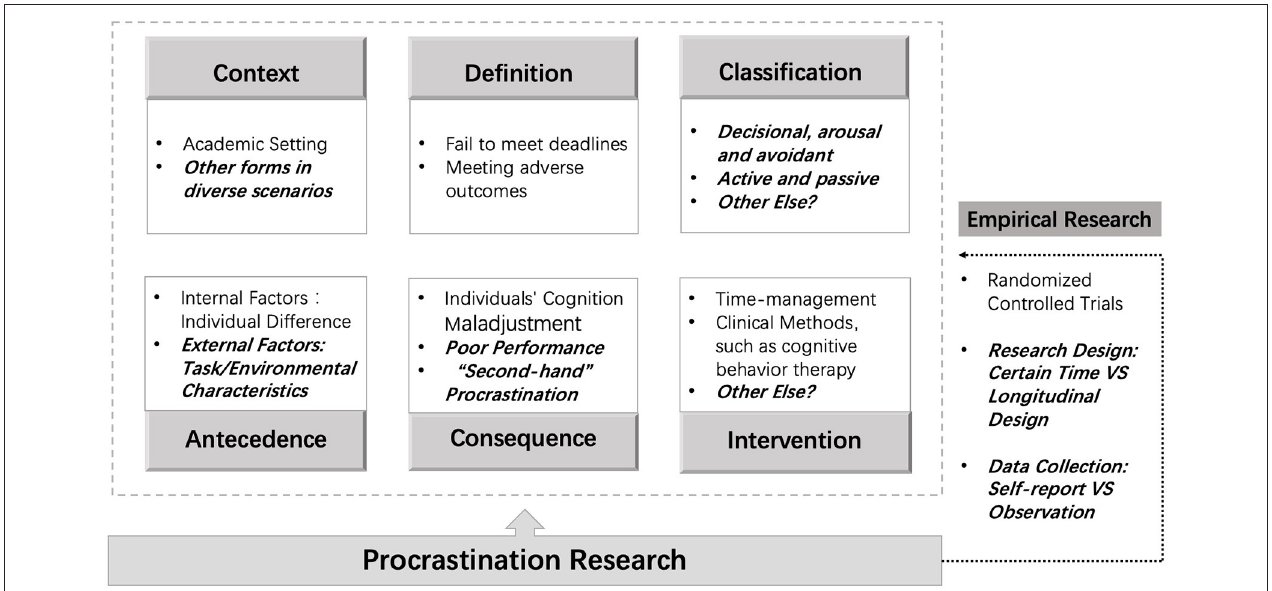
FIGURE 7 | Brief conclusions on procrastination